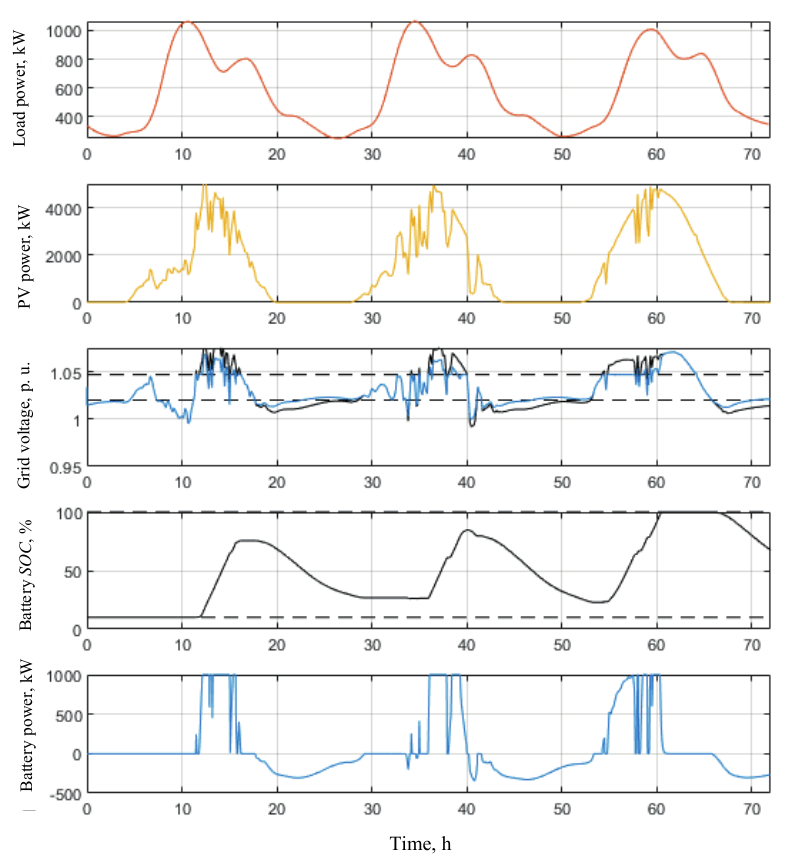
Fig. 8. Results for first three days in June considering a commercial load profile. The third panel shows the grid voltage: black line – without battery, blue line – with 5 MWh battery storage. Dashed lines indicate the limits for charging and discharging of the